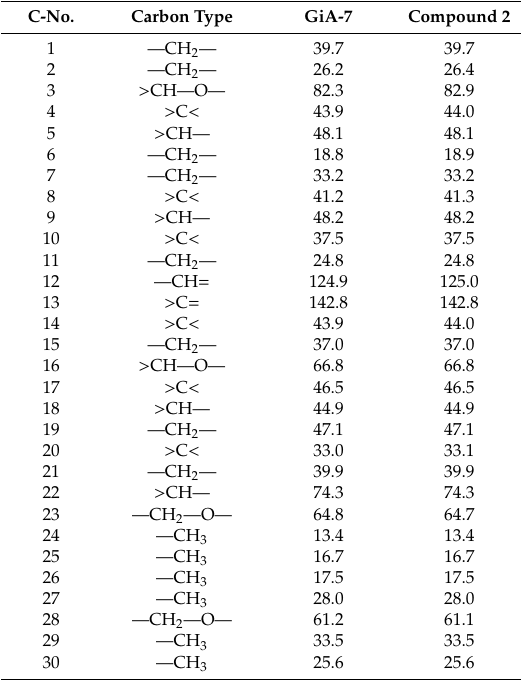
Figure 3. Ability of HPLC fractions to inhibit 3T3-L1 cell differentiation. ( a ) Inhibition of adipogenesis. ( b ) Cell proliferation. Values are shown as means ± SD ( n = 4). * p < 0.05, ** p < 0.01 and *** p < 0.001 vs. control (ANOVA and post hoc Dunnett tests). Table 2. 13 C nuclear magnetic resonance (NMR) chemical shifts of GiA-7 and compound 2 ( δ : ppm).